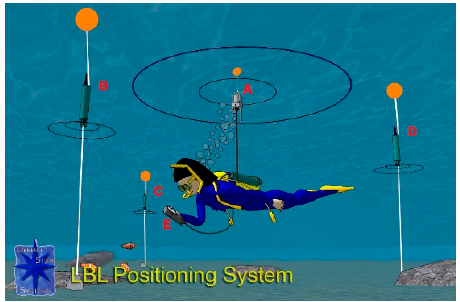
Figure 9. Method of the operation of a long baseline (LBL) acoustic positioning system [9] .